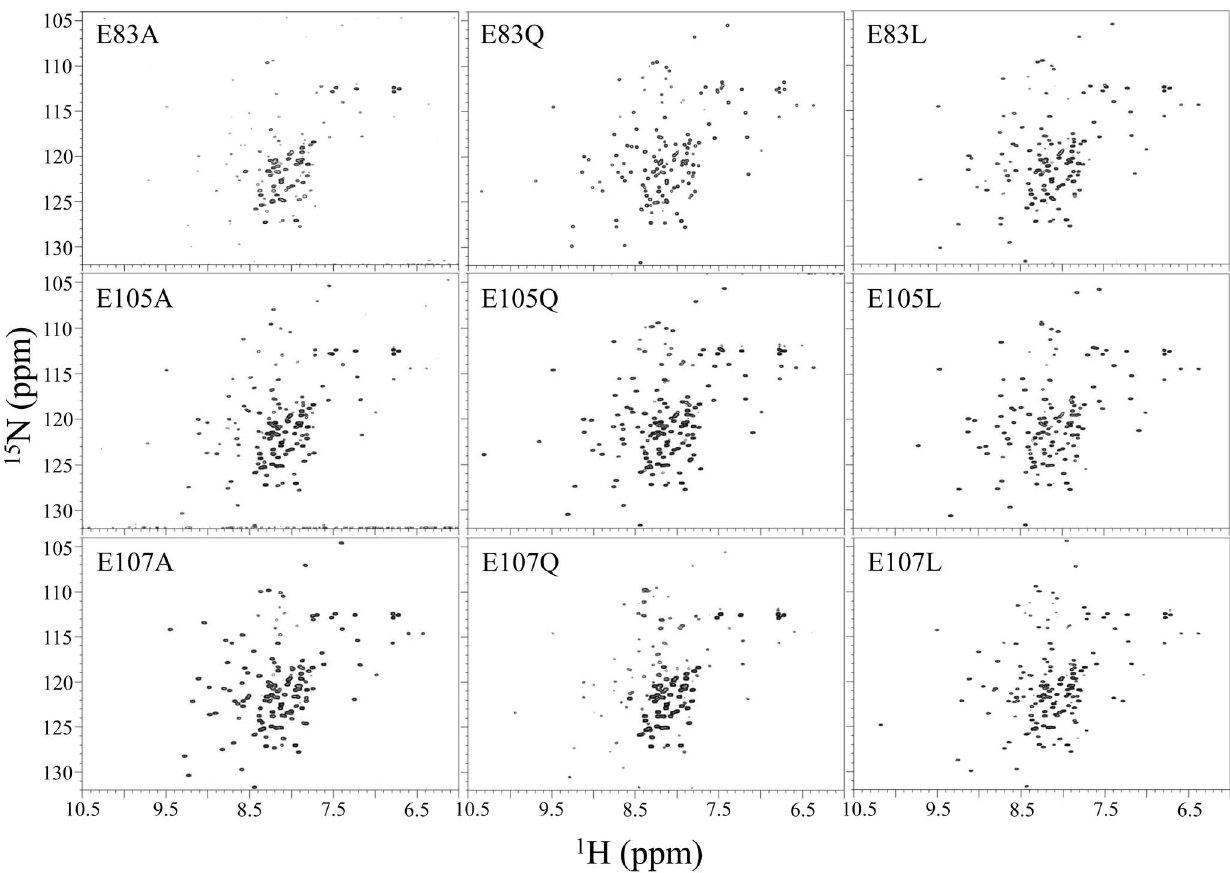
Figure 5. 1 H- 15 N HSQC spectra of the ESD mutants in 10 mM HEPES pH 7.5 and 100 mM NaCl. Each glutamate residue at positions 83, 105, or 107 is mutated to alanine, glutamine, or leucine. 1 H- 15 N HSQC spectrum of the wild type protein under the same conditions shown in the previous report [23].